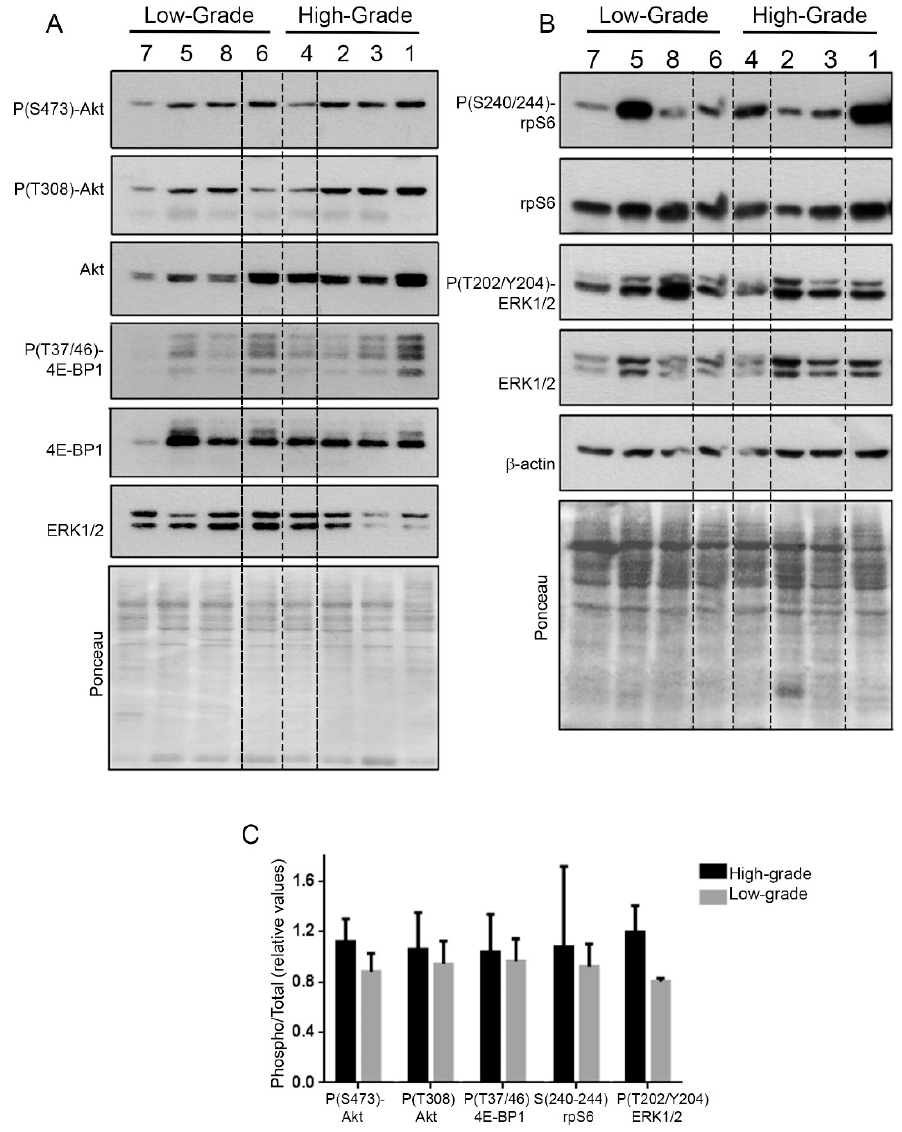
Figure 3. Histological grade is not associated with mTORC1 or ERK1 / 2 pathway activation. Tumor lysates from the eight fragments were analyzed by western blot to detect ( A ) P(S473)-Akt, P(T308)-Akt, Akt, P(Thr37 / 46)-4E-BP1, 4E-BP1, ( B ) P(240-244)-rpS6, rpS6, P(T202 / Y204)-ERK1 / 2, ERK1 / 2 and β -actin. ( C ) Quantification was performed by ImageJ software and Phospho / total ratios were plotted.